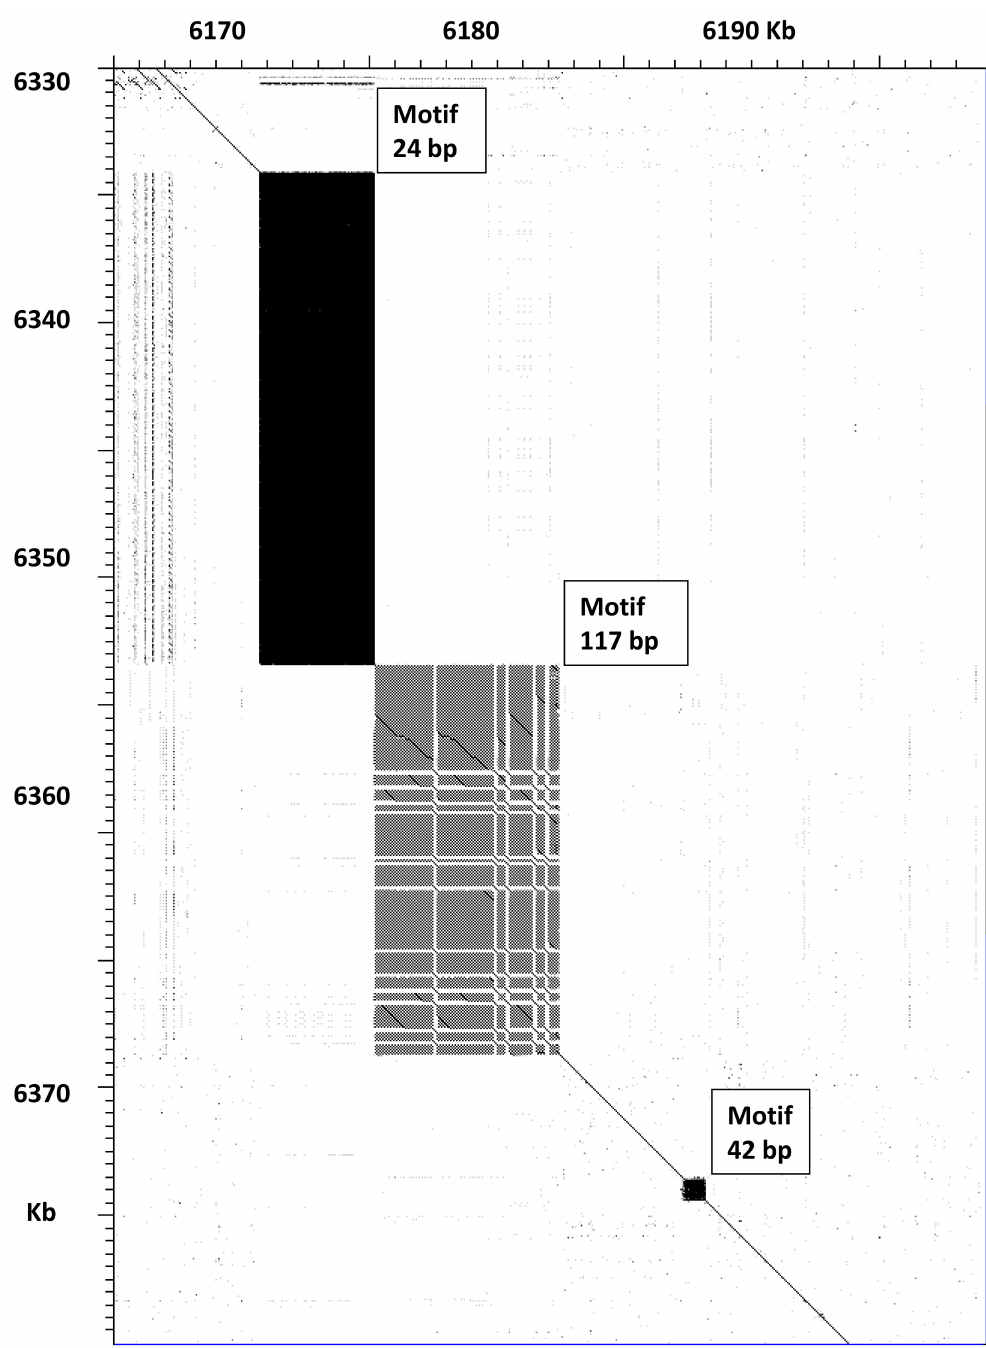
Figure 3. Comparison of satellite lengths in the titin gene of C. elegans. Dot plot of part of the titin gene ( ttn-1 ), demonstrating its expansion in the Nanopore VC2010 assembly. The figure was prepared with the Dotter program [13]. Coordinates are given in kilobases; WB235, chromosome V, in the abscissa, and VC2010 in the ordinate. This region has three satellites which correspond to amino acid repeats in the